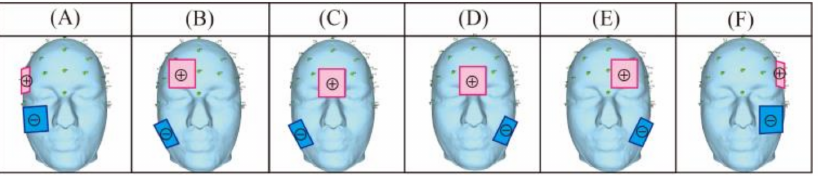
Figure 2. Electrode placements for stimulating the temporal, central, and nasal eyeball to present phosphenes in three positions: ( A ) electrode placement for stimulating the temporal right eyeball; ( B ) electrode placement for stimulating the central right eyeball; ( C ) electrode placement for stimulat- ing the nasal right eyeball; ( D ) electrode placement for stimulating the nasal left eyeball; ( E ) electrode placement for stimulating the central left eyeball; ( F ) electrode placement for stimulating the temporal left eyeball; the figures were produced by the authors using SimNIBS (29 September